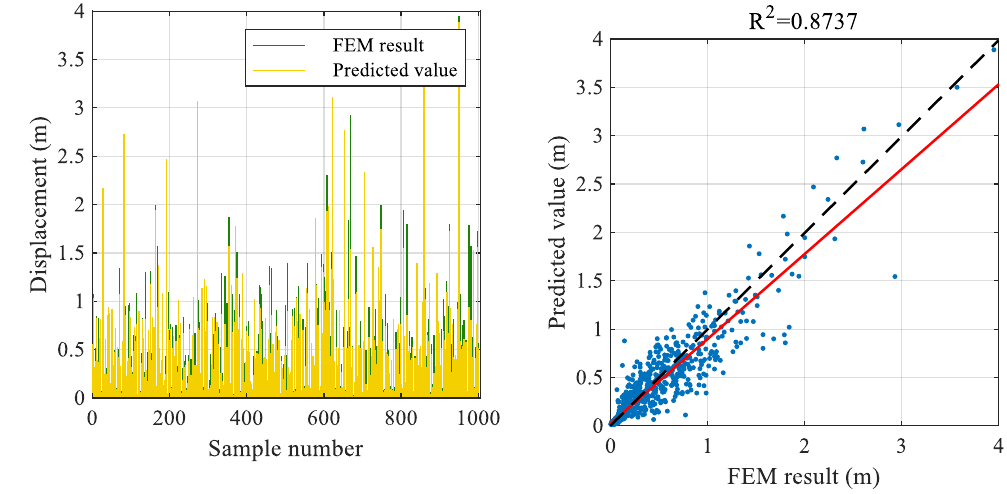
Figure 14. Test results of the CNN model. Table 4. Statistical indexes of prediction result.